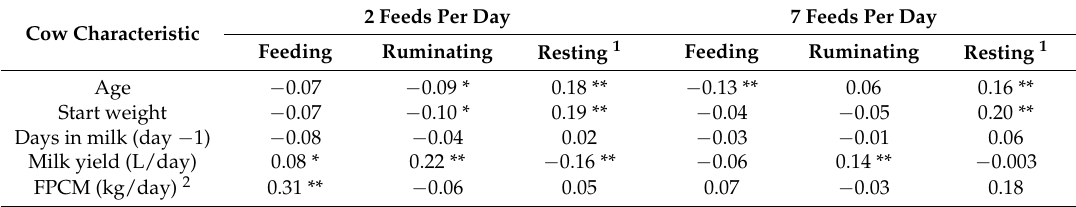
Table 4. Partial correlation coefficients (controlling for period, day, and paddock) between cow behaviour and variables relating to milk production and the cow, for cows fed pasture 2 or 7 times per